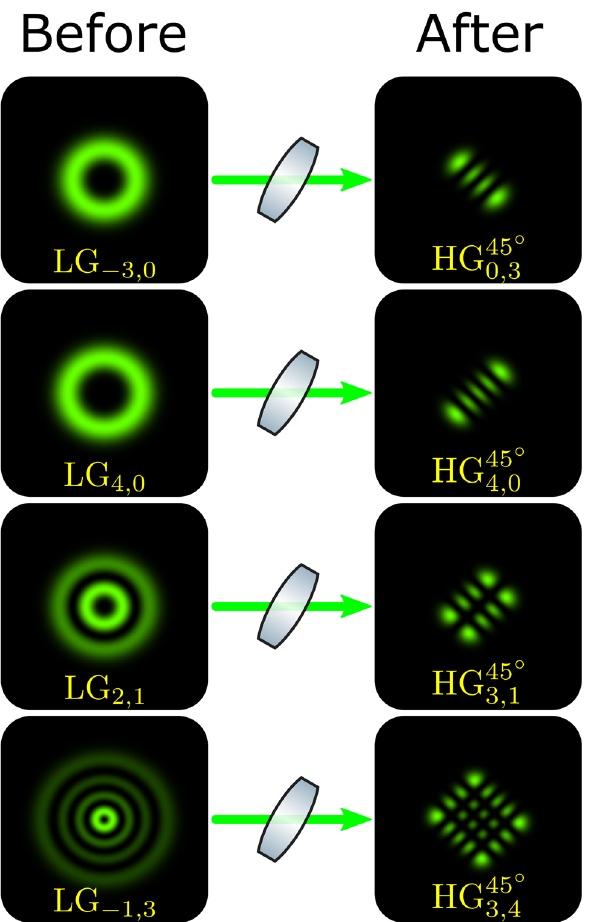
Figure 6: Transverse structure before and after the tilted